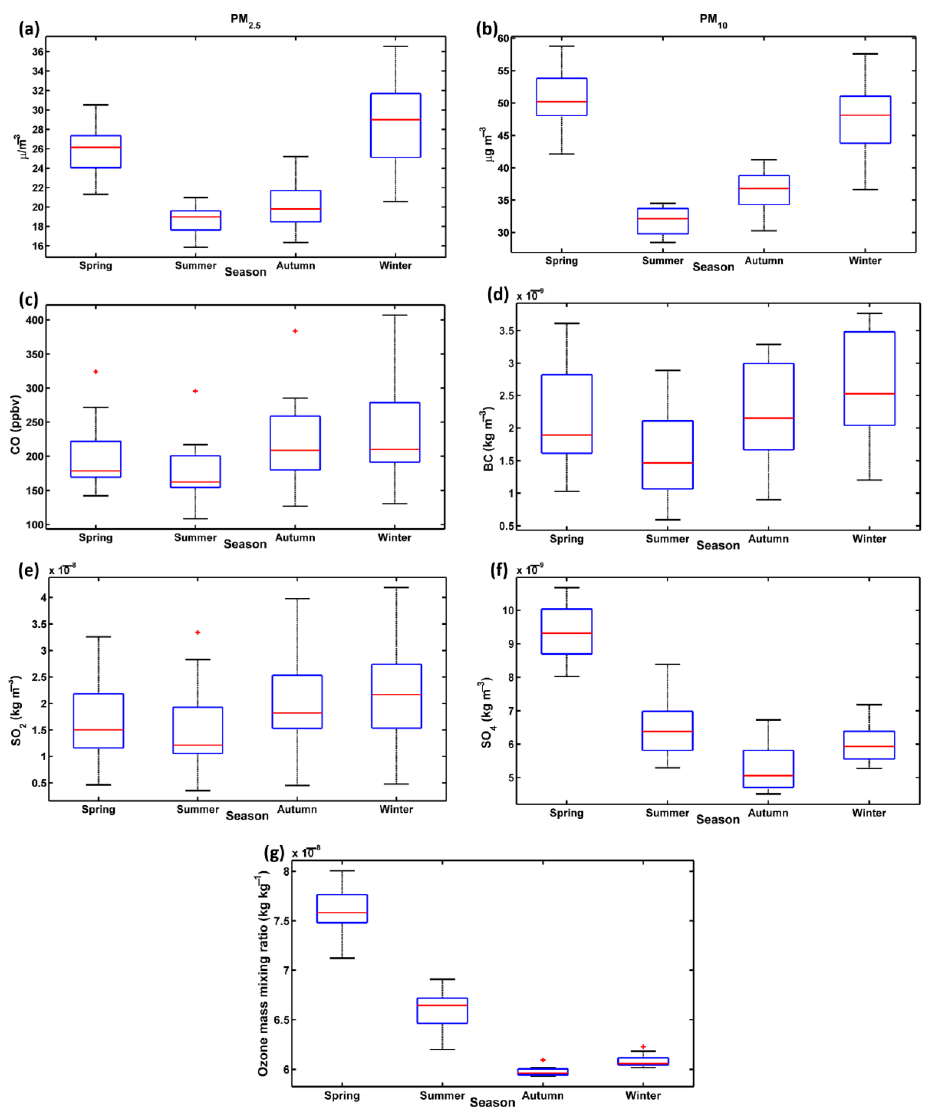
Figure 7. Seasonal mean values of particulate matter (PM) and other pollutants. The blue boxes represent the variations of the parameters, the lower and upper edges of the box are 25th and 75th percentiles, respectively, the red colored mark is the median, and the red plus symbols indicate outliers. ( a ) PM 2.5 , ( b ) PM 10 , ( c ) CO, ( d ) BC, ( e ) SO 2 , ( f ) SO 4 , and ( g ) ozone mass mixing ratio. they were low during autumn. The high values of PM 2.5 in winter were attributed to emis- sions from traffic, household heating and cooking, and industries, including coal-fired power plants, semiconductors, biopharmaceuticals, and cement [48 ]. The geography and climate of Korea, particularly wind direction, play an important role in PM concentration.